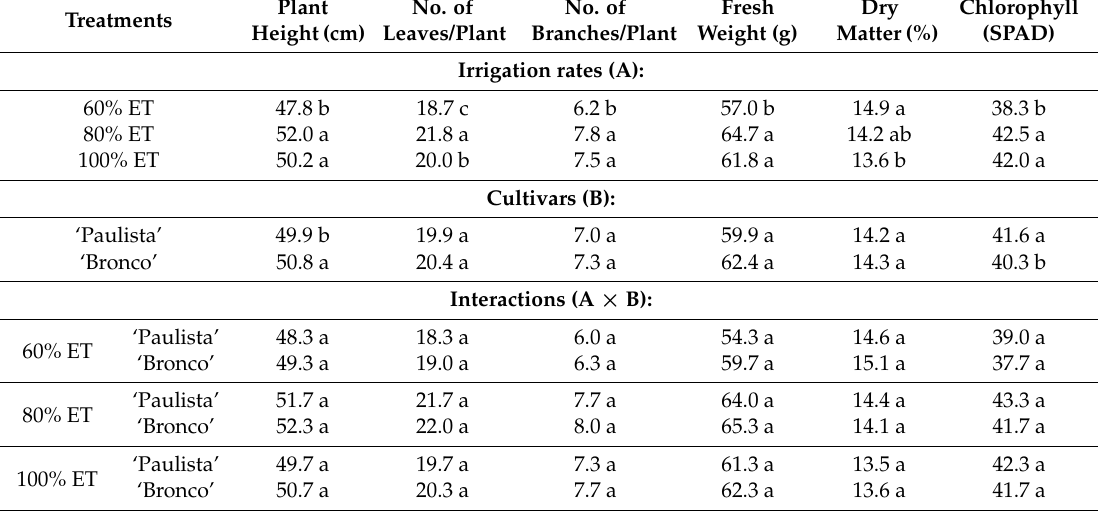
Table 2. Effect of different irrigation water volumes based on supplying 60, 80 or 100%